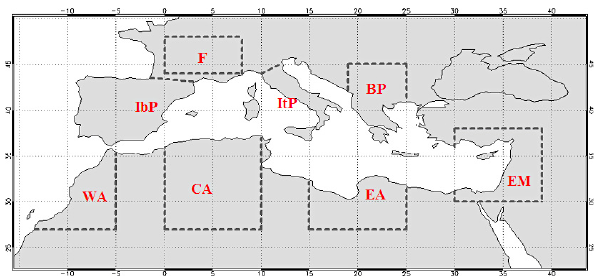
Fig. 1. The selected subregions of the Mediterranean Basin used to calculate the backward trajectories of ( E − P ). The regions indi- cated in red are: Iberian Peninsula (IbP), France (F), Italian Penin- sula (ItP), Balkan Peninsula (BP), Eastern Mediterranean (EM) and Western, Central and Eastern North Africa (WA, CA and EA, re-